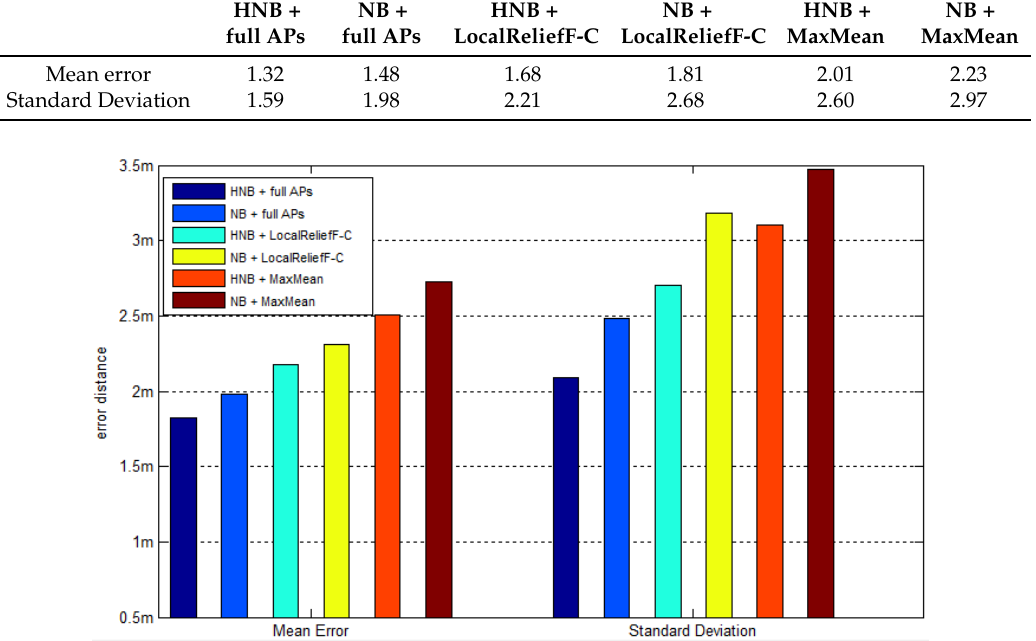
Figure 16. Mean error distance and standard deviation of the six systems.